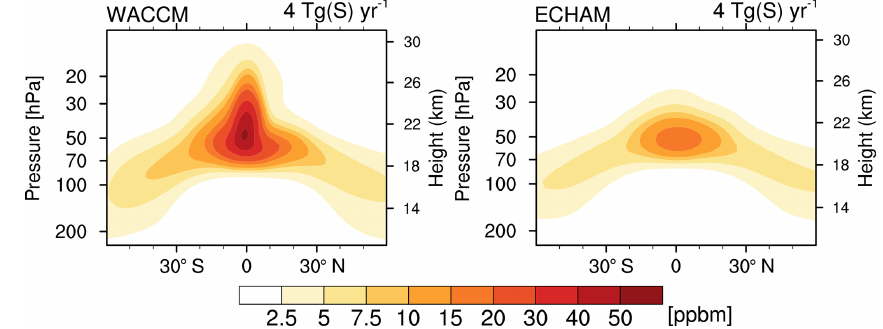
Figure 5. Zonally averaged sulfate concentration (ppbm) of injections of 4Tg ( S ) yr − 1 for WACCM and ECHAM.